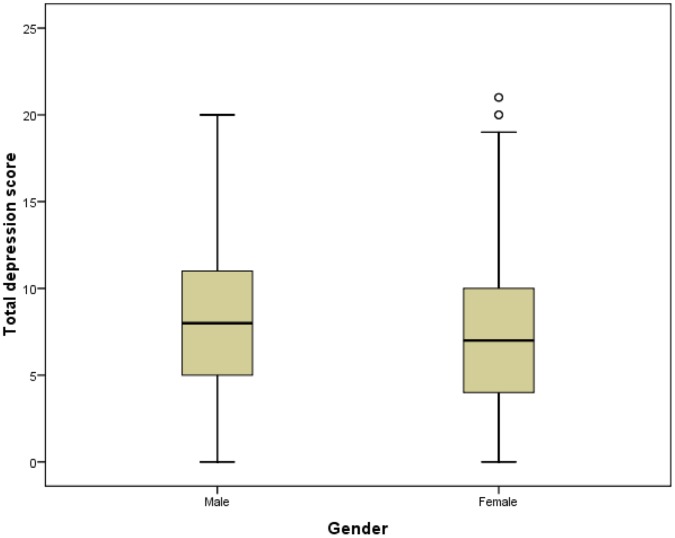
Depression scores for men and women.The depression scores for men and women are indicated. It can be seen that the men’s scores are higher than women’s.